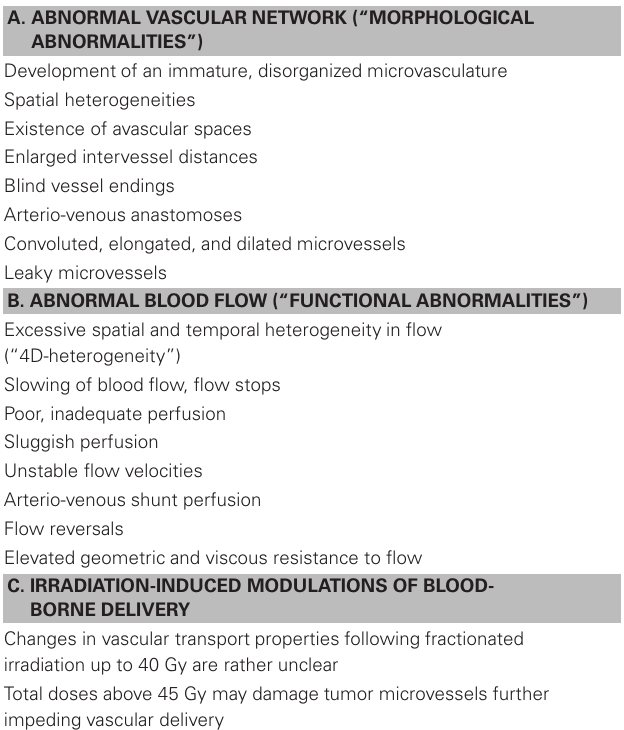
Table 2 | Obstacles to transvascular transport (extravasation) of macromolecular therapeutic and diagnostic agents in solid